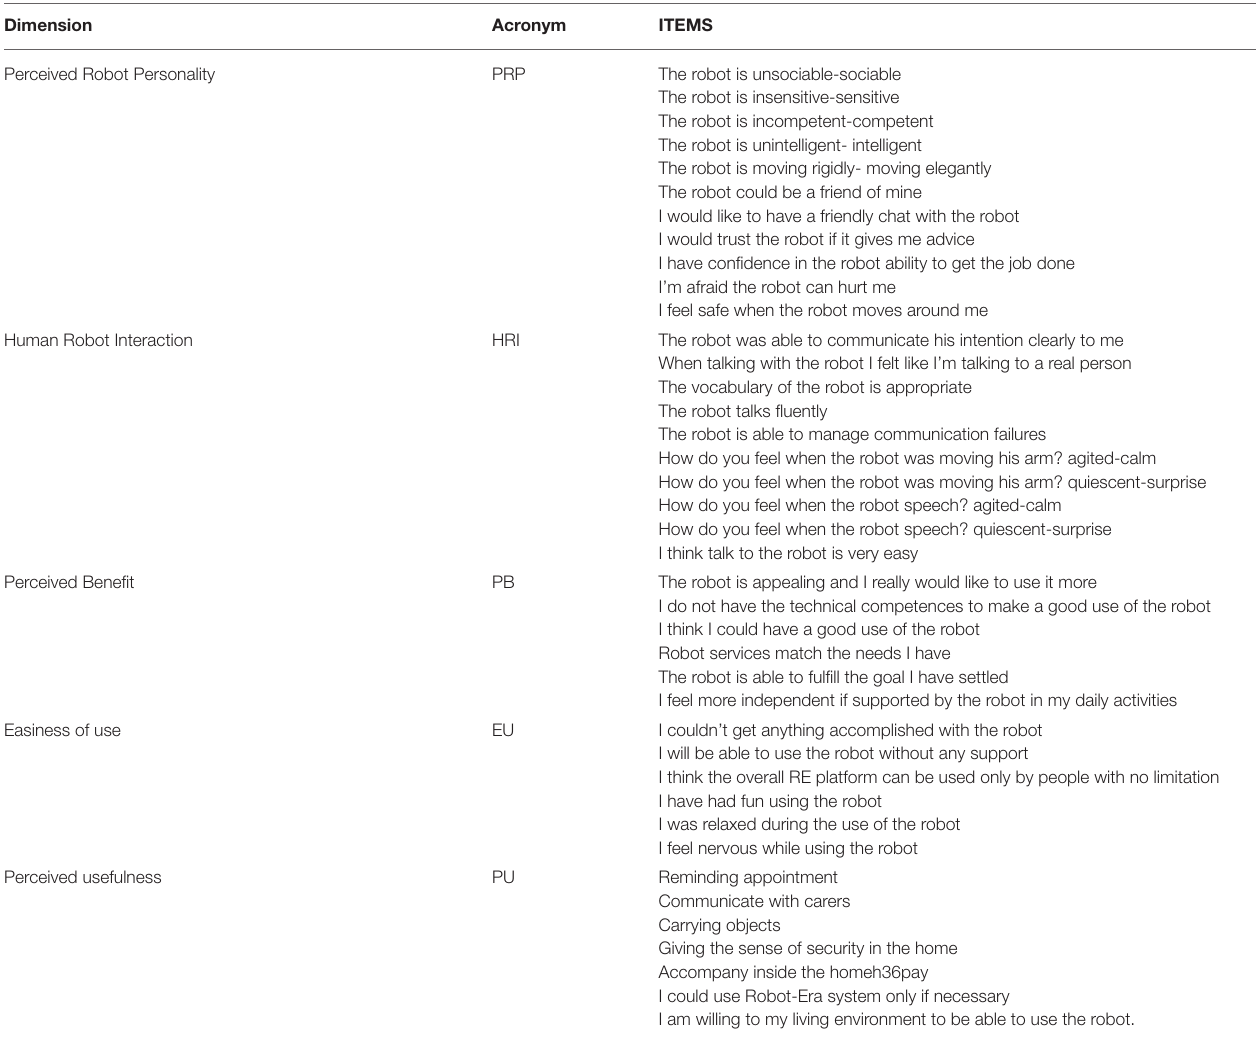
TABLE 1 | Items selected for the inventory.